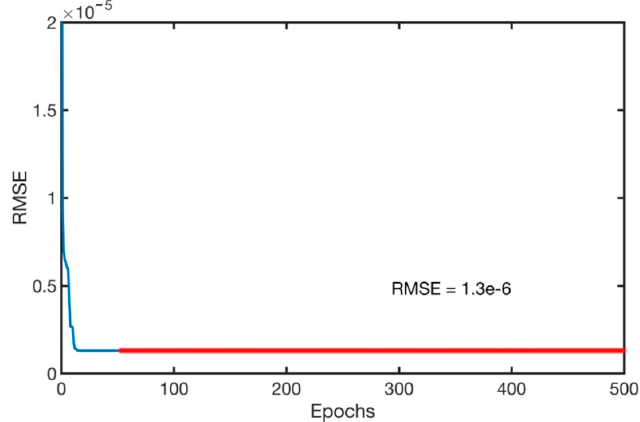
Figure 5. Training epochs vs. root mean square error (RMSE) for the dry turning process.